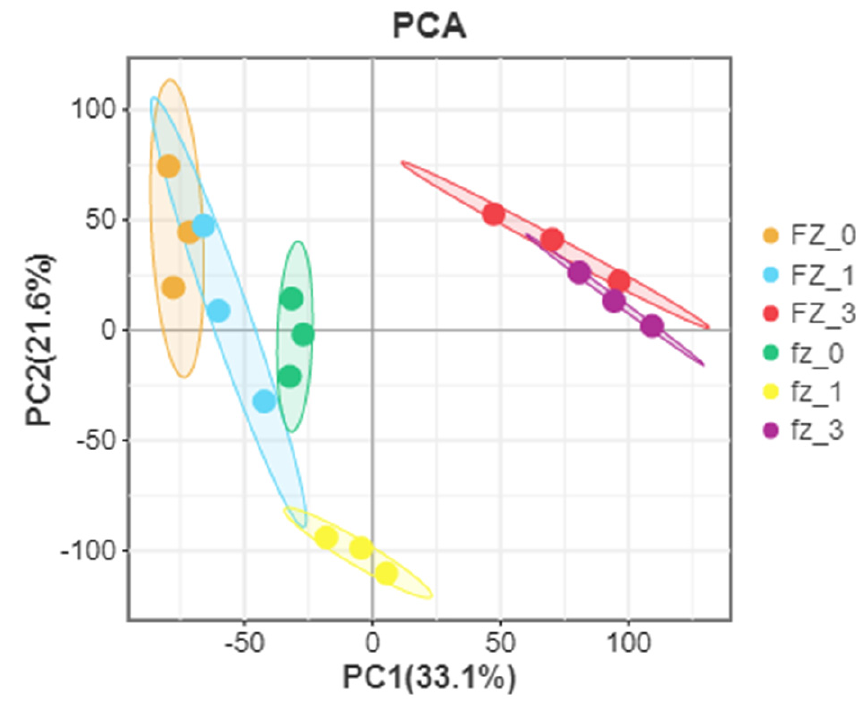
Figure 2. PCA analysis of Xinluzao 50 (fz) and Xinluzao 50 FLM (FZ).